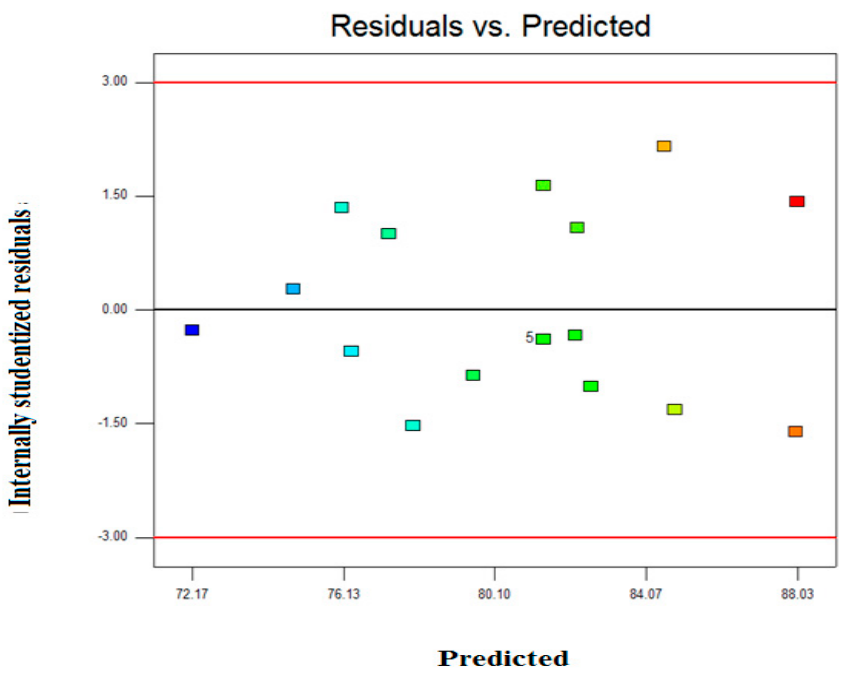
Figure 3. Internally studentized residual versus predicted Zn 2+ removal.